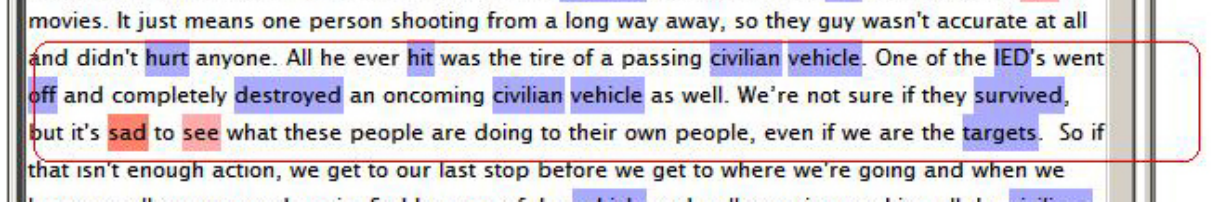
Another example of the proximity of the words related to the 2 paragraph in Figure 3. The purple labels mark the combat events and locations, while the red and brown mark the words from the emotions category.